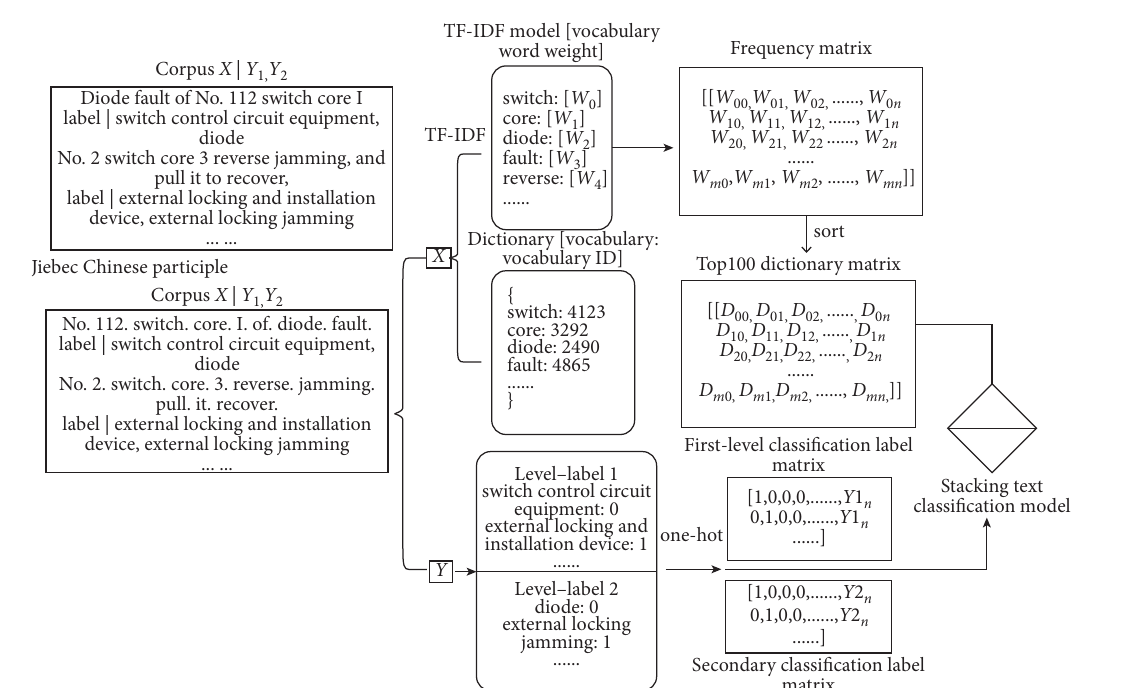
Figure 1: The feature extraction process of the high-speed railway signal fault text.